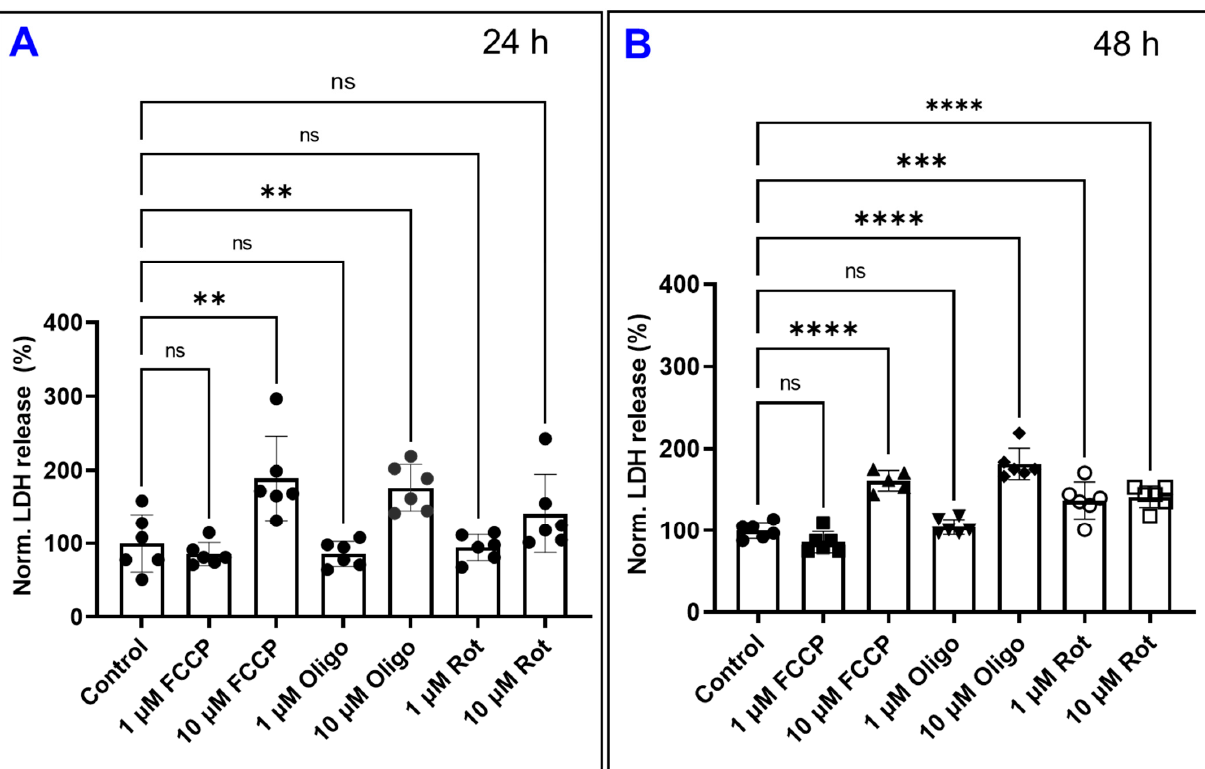
Figure 11. Effects of different mitochondrial inhibitors on HREC viability. The amount of lactate dehydrogenase (LDH) released after treatment with various mitochondrial inhibitors at ( A ) 24 h and ( B ) 48 h. Statistical analysis was performed using the ANOVA test followed by the Tukey post hoc test. Abbreviations: Norm, normalized; ****, p ≤ 0.0001; ***, p ≤ 0.001; **, p ≤ 0.01; ns, no